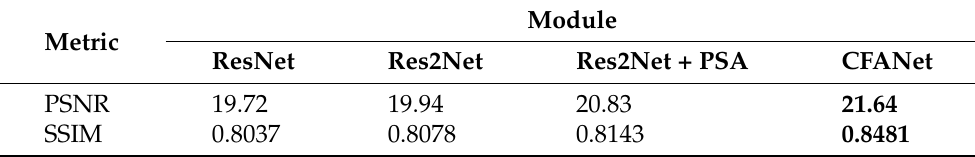
Table 4. Ablation results of network structure on LOL dataset. The best results are in bold.